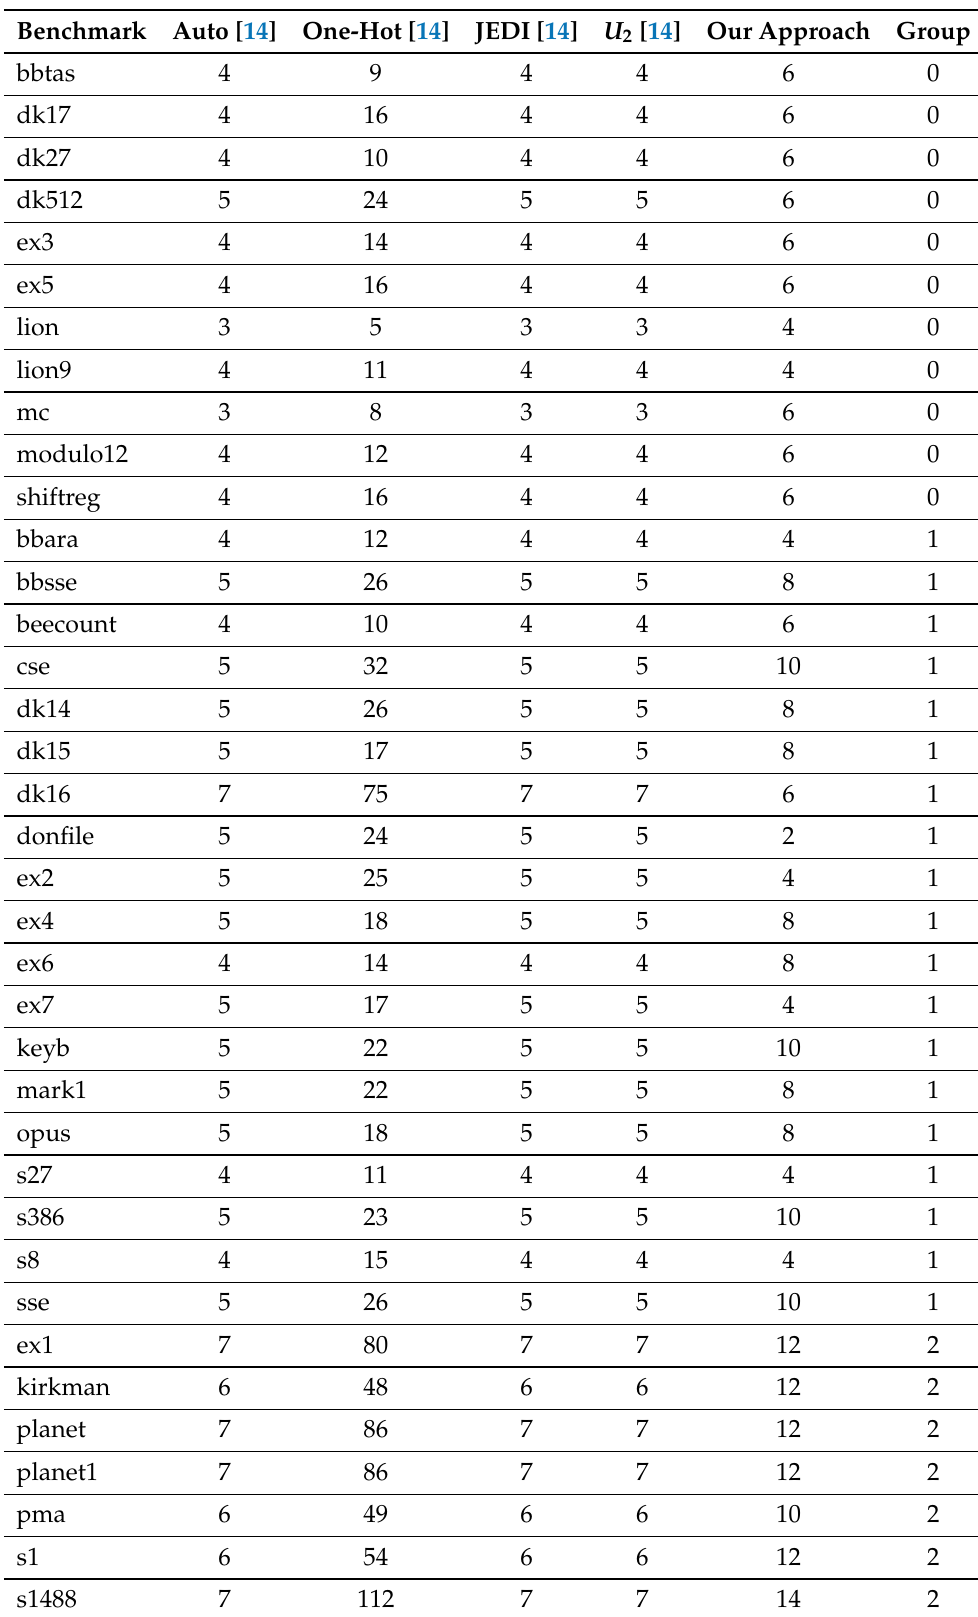
Table 16. Experimental results (number of